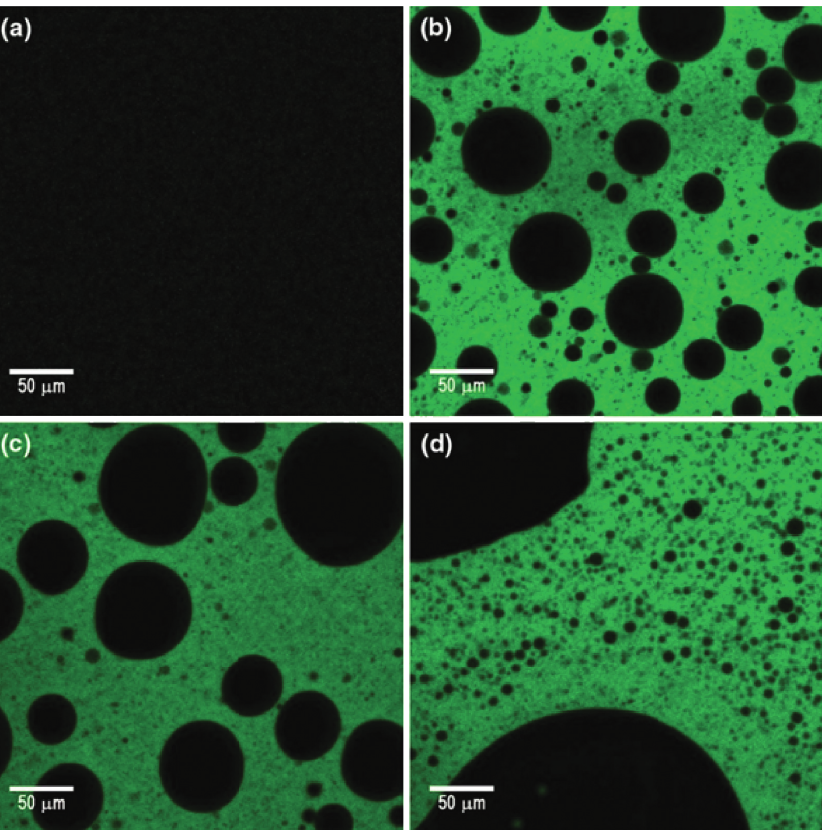
Figure 9: LSCM images in the reflection mode for cured neat epoxy (a), HMEAs: HMEA45 (b), HMEA50 (c), and HMEA55 (d) [7]. HMEA � hot-mixed epoxy asphalt; 45, 50, 55 � asphalt content by weight of HMEA binders.